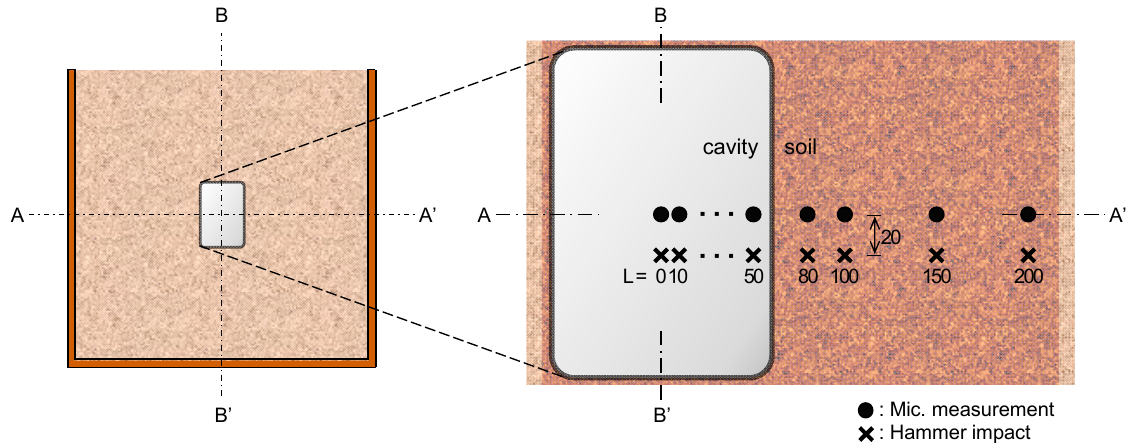
Figure 5. Measurement locations at cavity and soil sections. Units are given in mm.